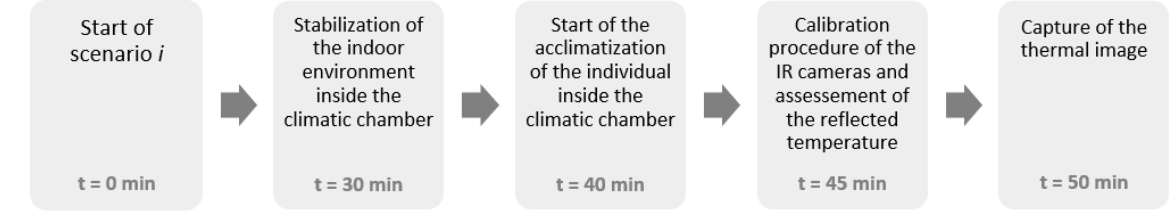
Figure 2. Set of procedures in each tested scenario.